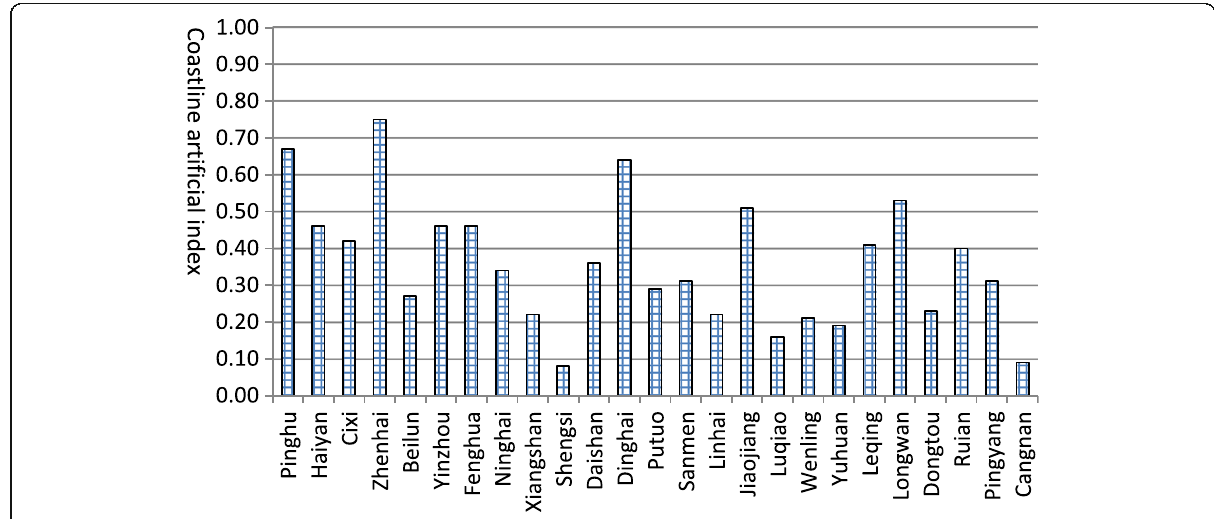
Fig. 3 The coastline artificial index in 25 sections of